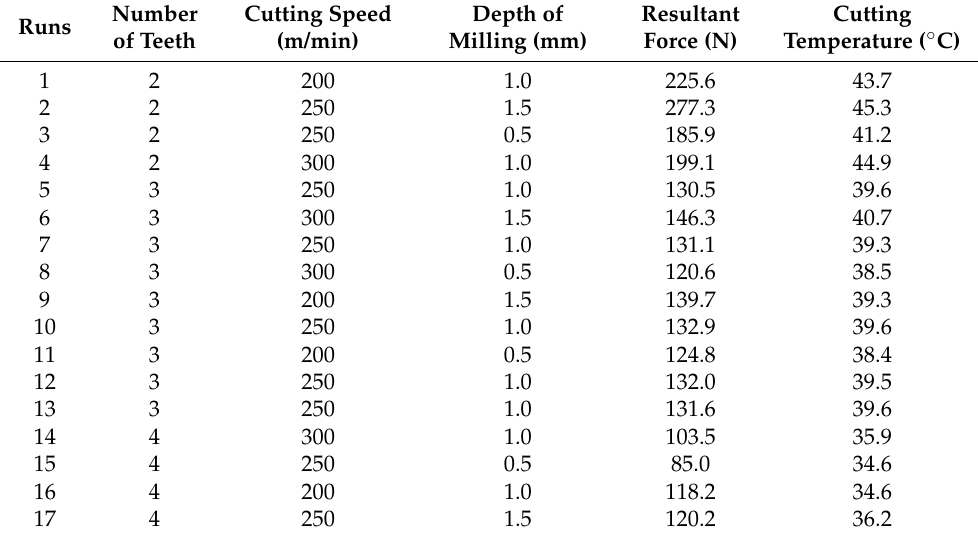
Table 4. RSM design and results.